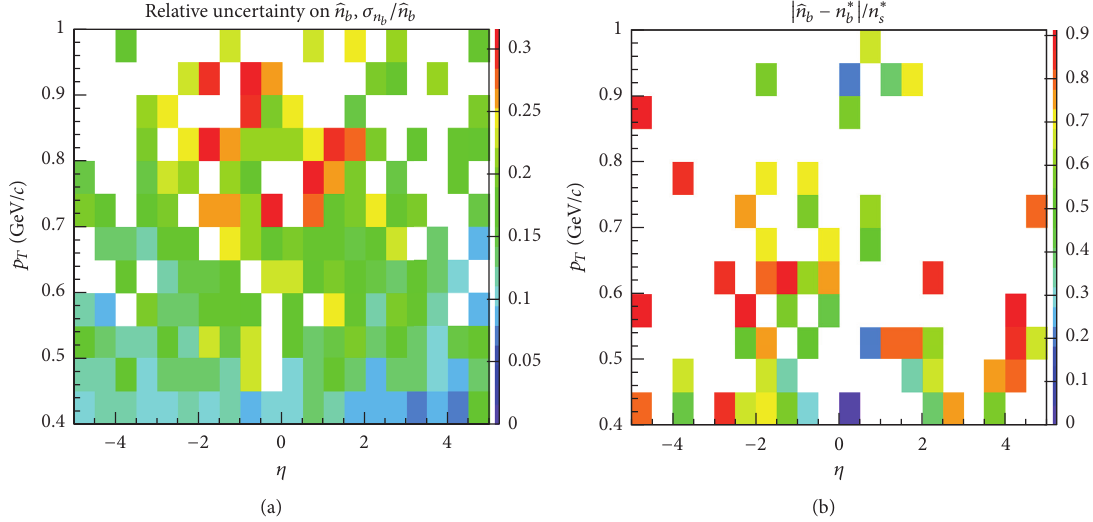
/̂𝑛 𝑏 , represented as a heatmap across the 𝑏